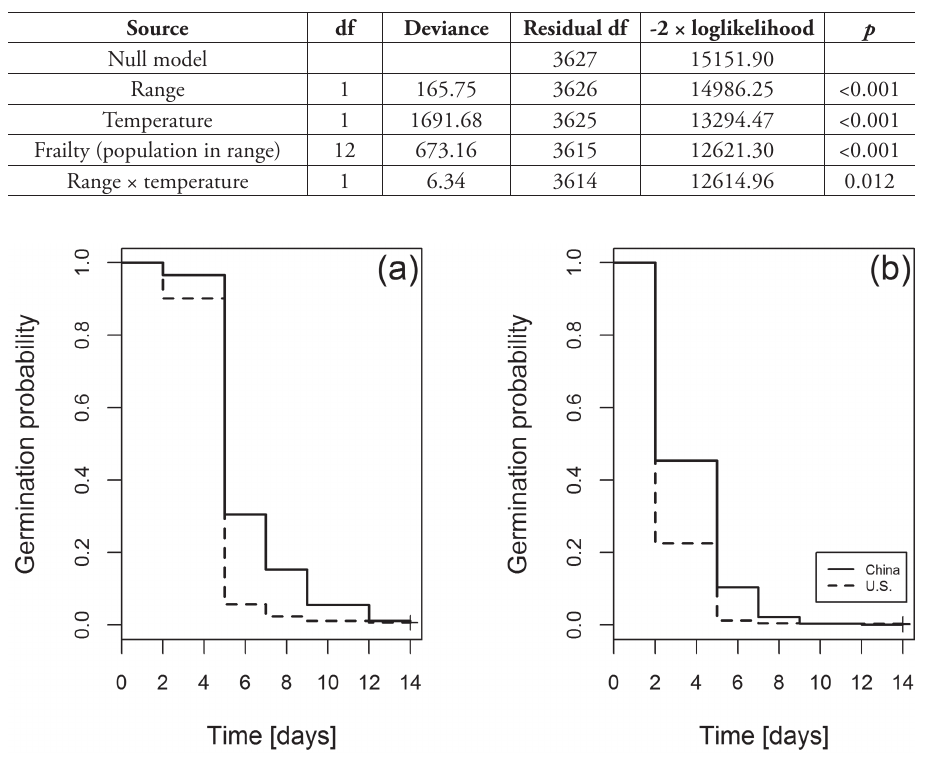
Figure 3. Kaplan-Meyer curves of the germination functions for the non-native and native origins of Ulmus pumila. Curves are shown for the two temperature treatments ( a : 20°C/10°C; b : 32°C/20°C). Censored data is symbolized by final crosses at the curves. The curves show the probability that seeds will germinate. Therefore, the germination probability has to be 1.0 at time = 0 because all seeds are non- germinated and have consequently the chance to